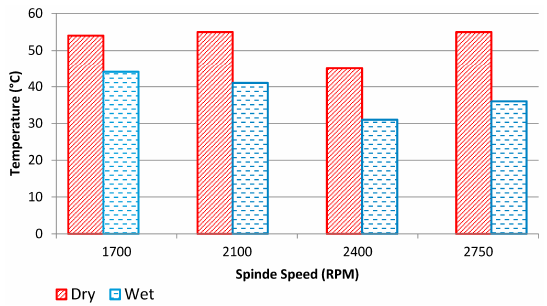
Figure 8. Peak drilling temperatures.